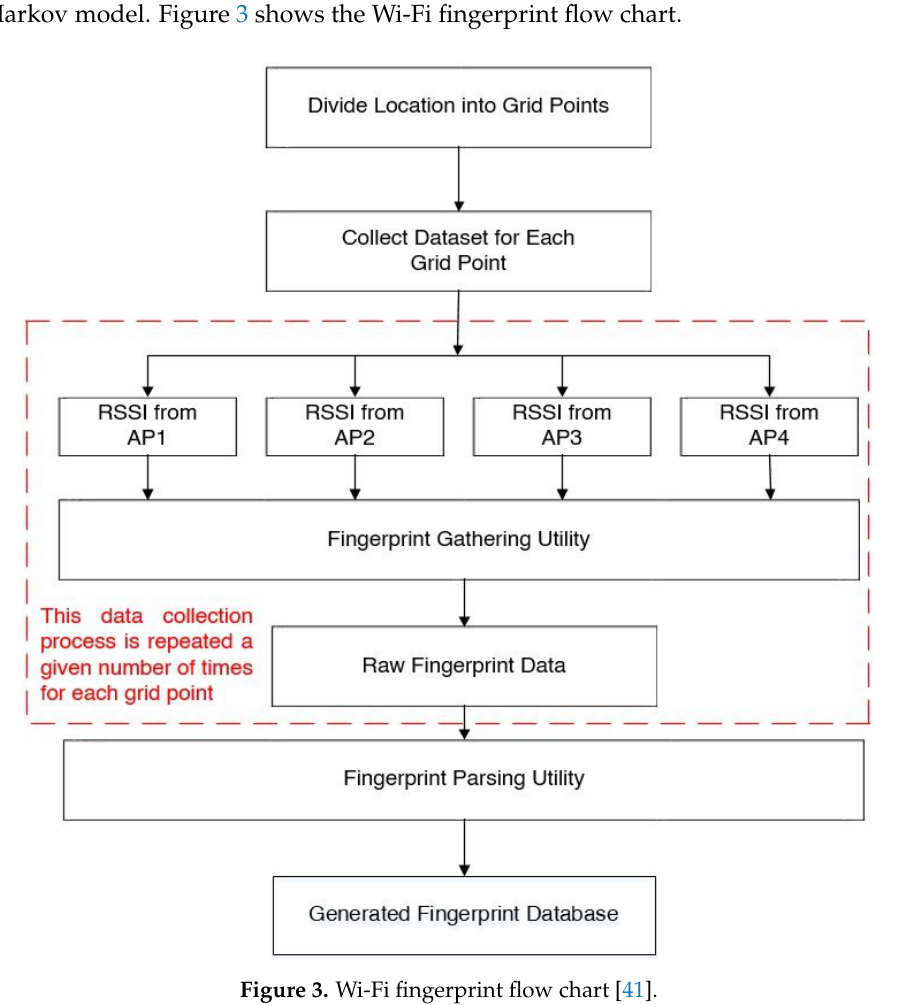
Figure 4. The location estimation procedure uses the localization algorithm on the fingerprint maps of the four APs and the received RSSI samples on-the-fly. The nearest neighbor method is used